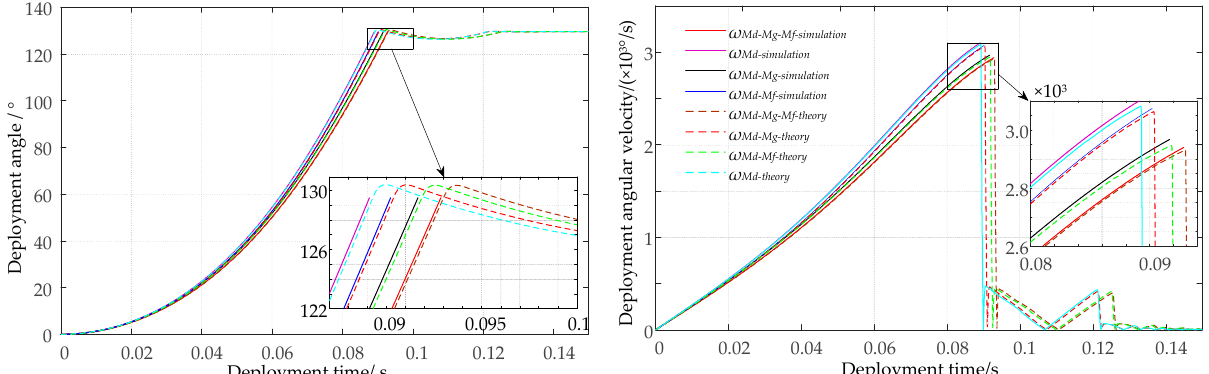
Figure 9 compares the theoretical and simulation results. The solid lines represent theoretical results, while the dotted lines represent the simulation results. the theoretical results, while the dotted lines represent the simulation results.